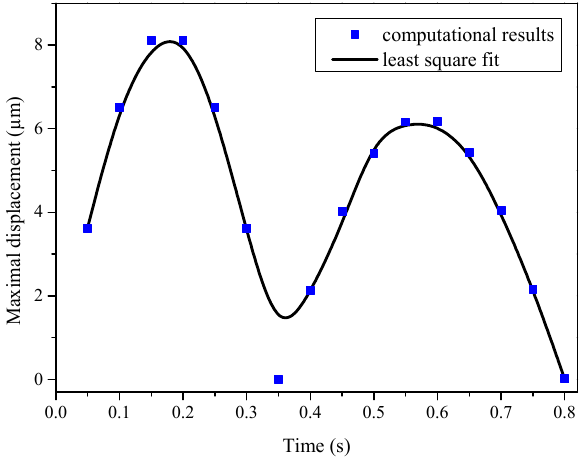
Figure 9. Temporal evolution of the maximal displacement.